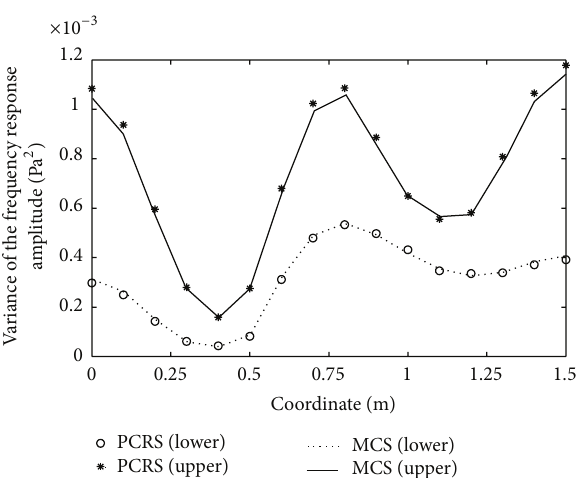
Figure 9: The lower and upper bounds of variance of the frequency response amplitude at uncertain level